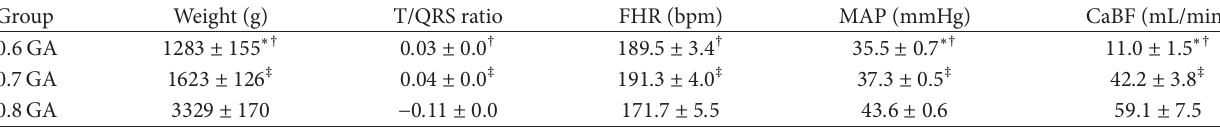
Table 1: Baseline physiological